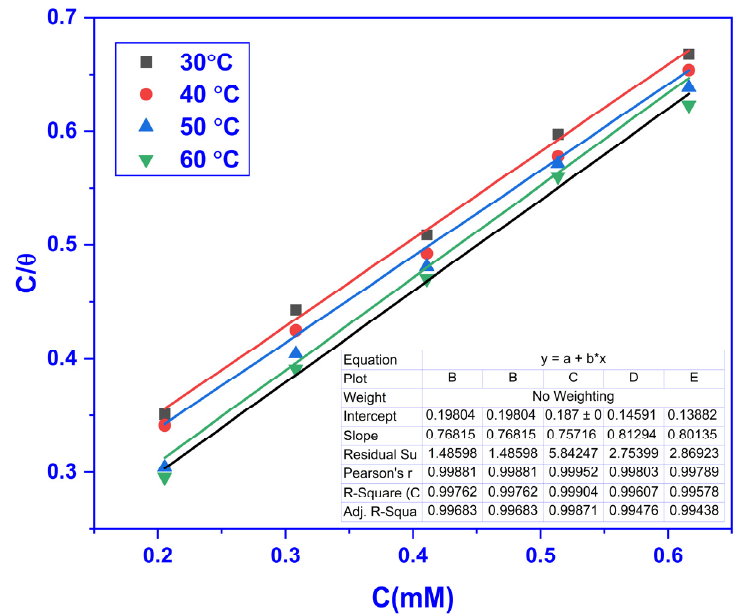
Figure 4. Plots showing the LAI for MS at varying CMEA doses in 1 M HCl.